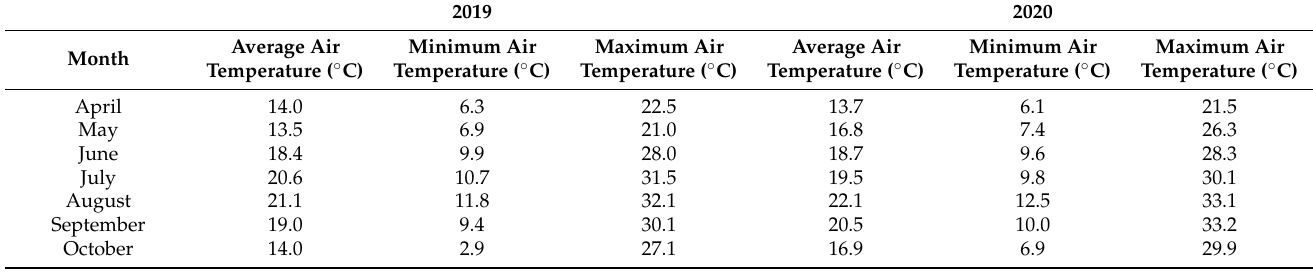
Table 2. Monthly average air temperature, minimum air temperature, and maximum air temperature for Atascadero, California (USA) weather station 163 during the 2019 and 2020 growing season.